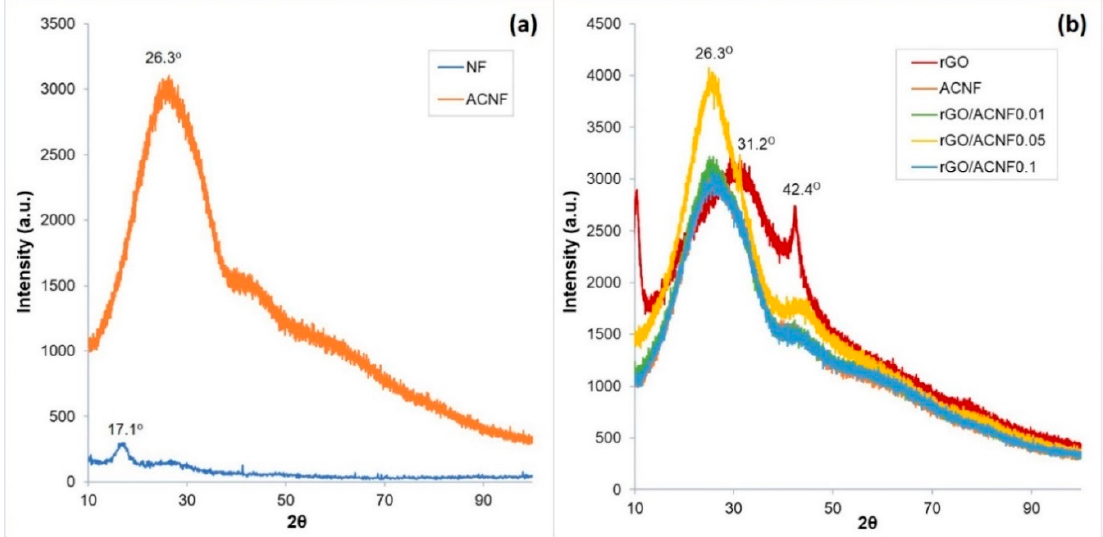
Figure 4. XRD spectra of ( a ) pristine NF and ACNF; and ( b ) rGO, ACNF, and rGO/ACNFs.